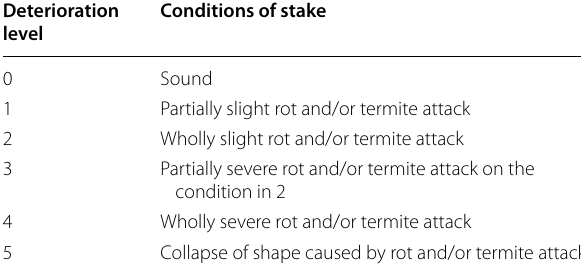
Table 3 Deterioration level